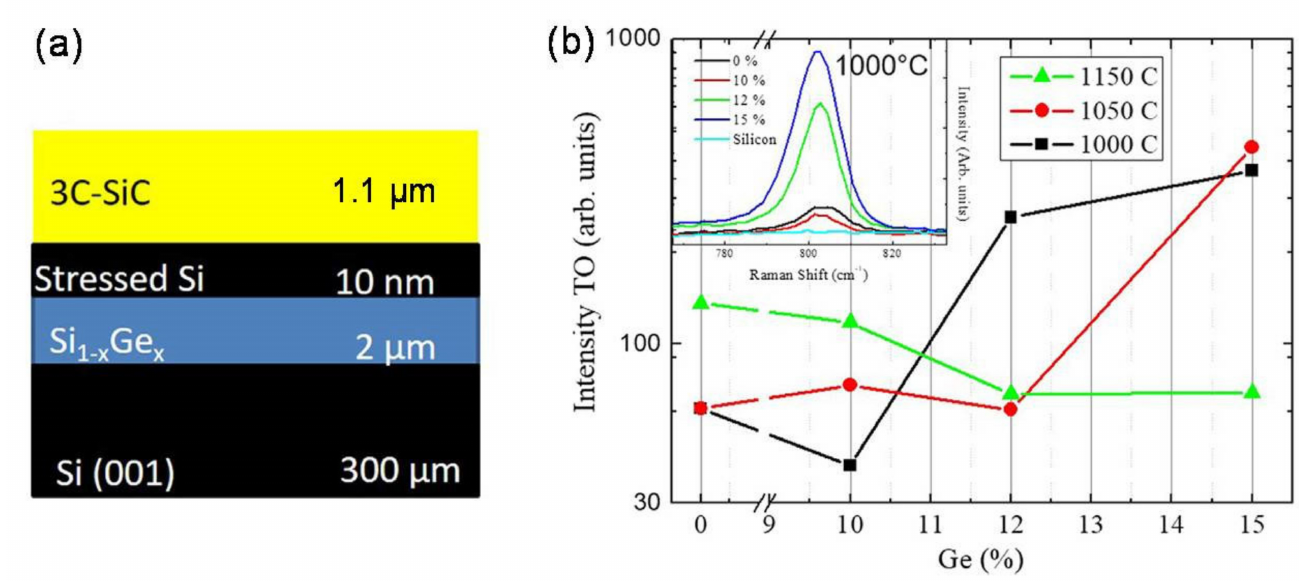
Figure 7. ( a ) Schematic of the sample structure. The image is not to scale. ( b ) 3C-SiC TO peak height with respect to nominal Ge concentration for several carbonization temperatures. The spectra of samples that have undergone 1000 ◦ C carbonization are shown in the inset (adapted from Reference